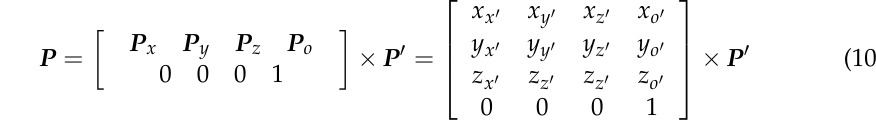
where, P x, P y, and P z represent the direction vectors of O’X’, O’Y’, and O’Z’ in the global measurement coordinate system. The above algorithm was used to compensate for static errors of the rotary stages. Calculate the distances dis_z i between corresponding points in the virtual point clouds and the optimized point clouds along the Z axis, which can explain the compensation effect and the reliability of the optimized rotary axis: